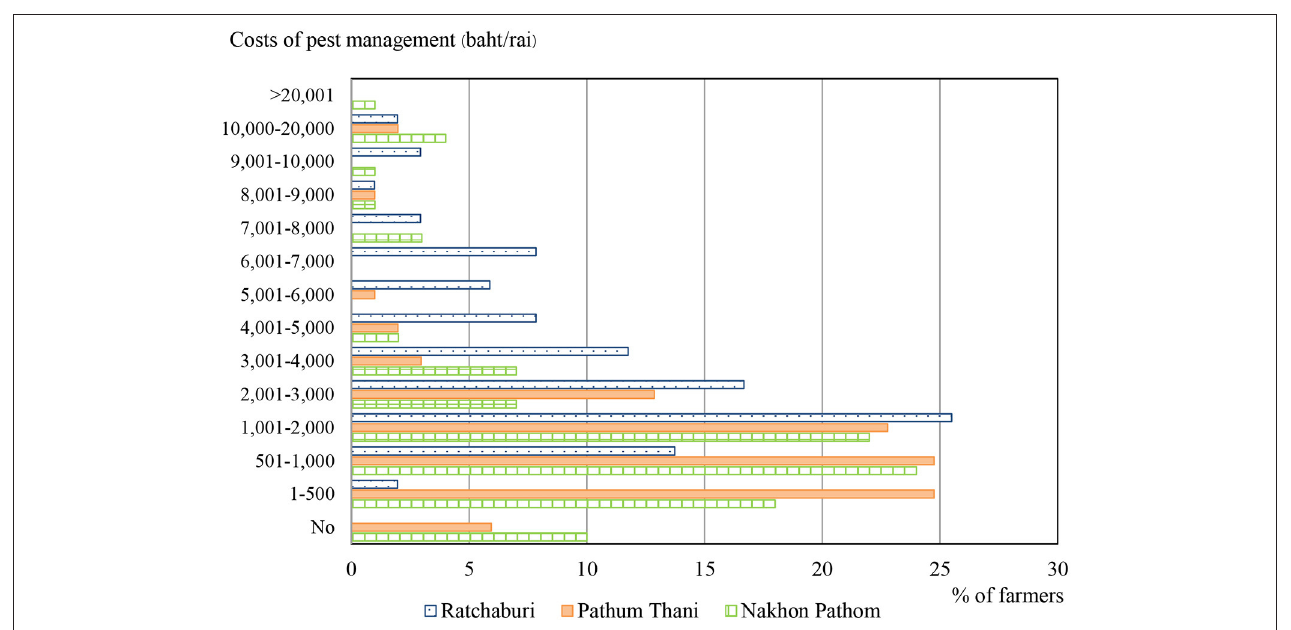
FIGURE 3 | Cost of pest management among vegetable growers in Nakhon Pathom, Pathum Thani and Ratchaburi provinces, 2016.